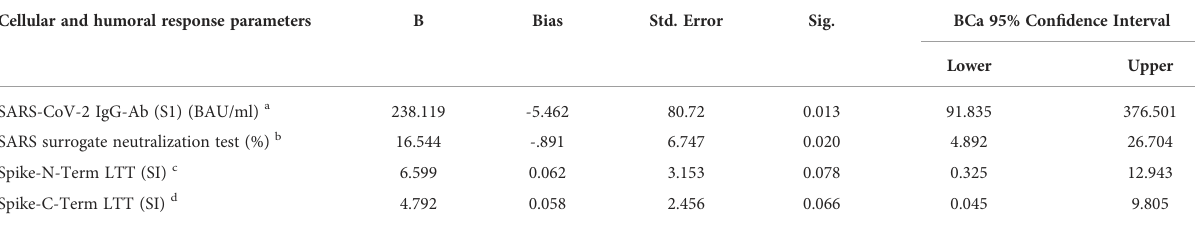
The multiple regression models were performed with humoral and cellular response parameters as one dependent variable, respectively, i.e., SARS-CoV-2 IgG-Ab (S1) (BAU/ml) in model a, and R 2 of the model is 0.255; SARS surrogate neutralization test (%) in model b, and R 2 of the model is 0.194; Spike-N-Term LTT (SI) in model c, and R 2 of the model is 0.304; Spike-C- TermLTT(SI)inmodeld,andR 2 ofthemodelis0.260.Weincludeconfoundingfactorssuchasage(years),sex(M/F),BMI(bodymassindex,calculatedasweightinkilogramsdividedby height in meters squared), diabetes (yes/no), hypertension (yes/no), chronic obstructive pulmonary disease (COPD) (yes/no), asthma (yes/no), smoking (yes/no), time from infection to blood collection (days) into the models. BCa, Bias-corrected and accelerated. Details of the individual models are shown in Supplementary Table